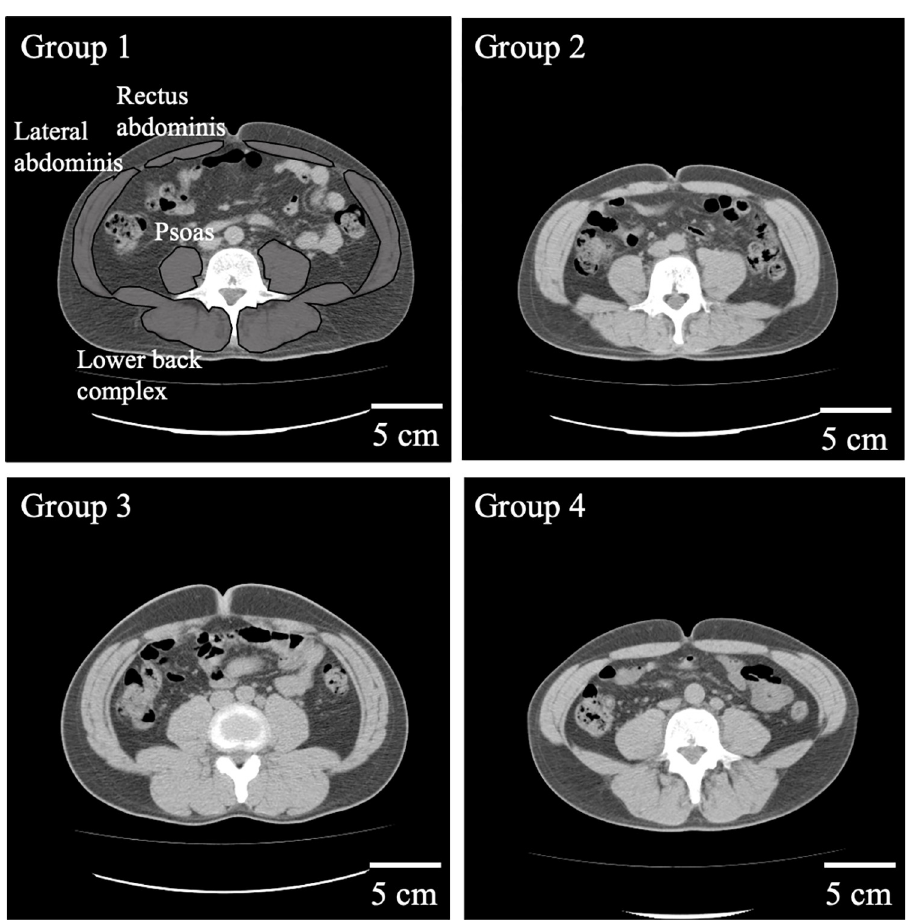
Fig 1. Representative computed tomography images of the trunk in Groups 1 to